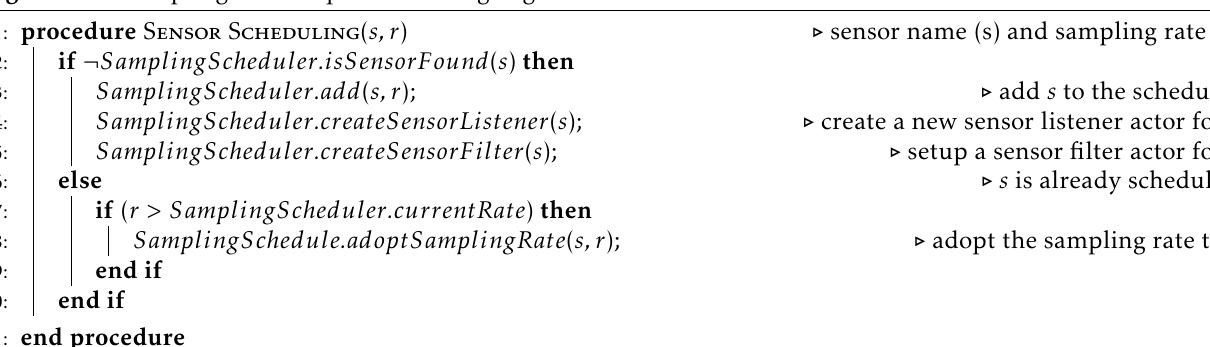
Algorithm 1 Sampling Rate Request Handling Algorithm